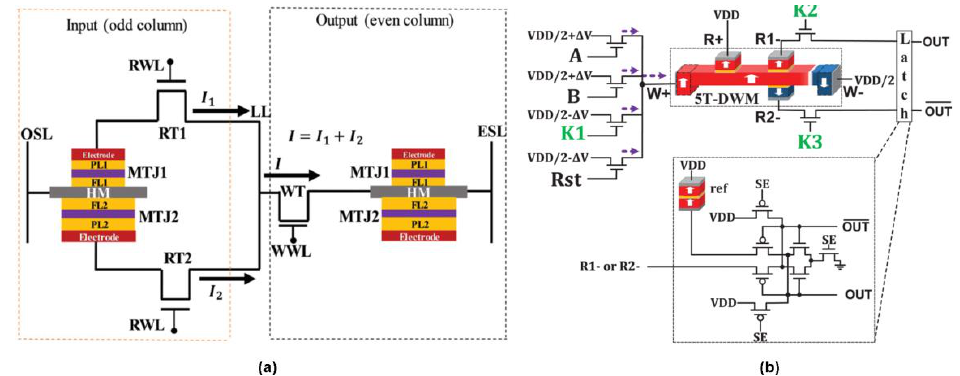
Figure 8. ( a ) Two input logic gate realization using MV-SOTM (SOT-based magnetic memory) in-memory computing architecture; ( b ) proposed hybrid polymorphic logic gate (HPLG) circuit